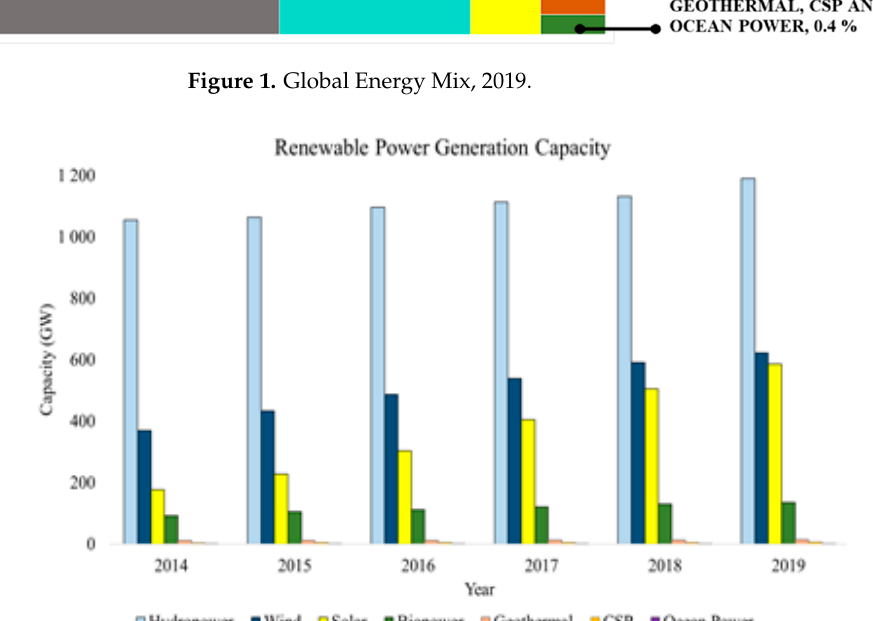
Figure 2. Global renewable energy (RE) generation capacity.